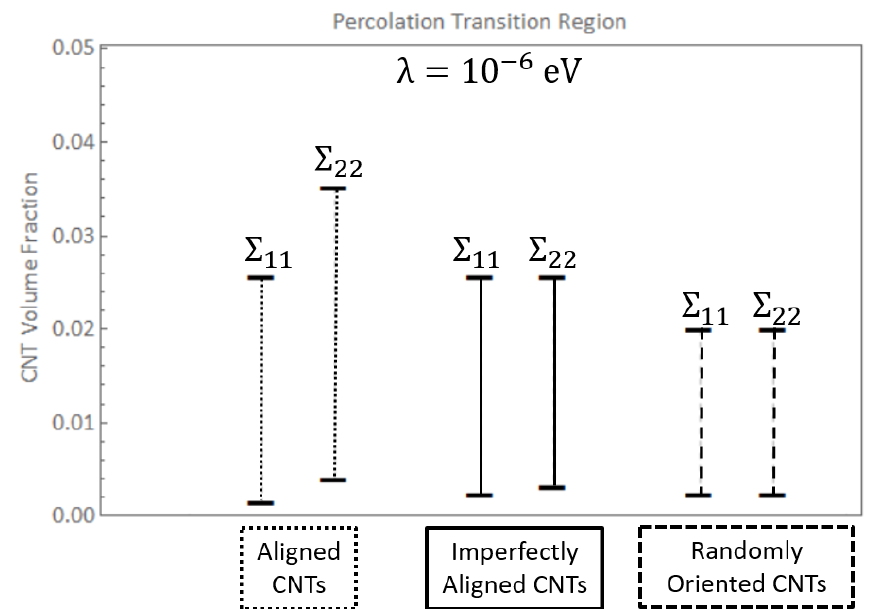
Figure 15. Percolation transition region shown for Σ 11 and Σ 22 for straight ˜ x 1 aligned, straight ˜ x 1 imperfectly aligned and straight randomly oriented